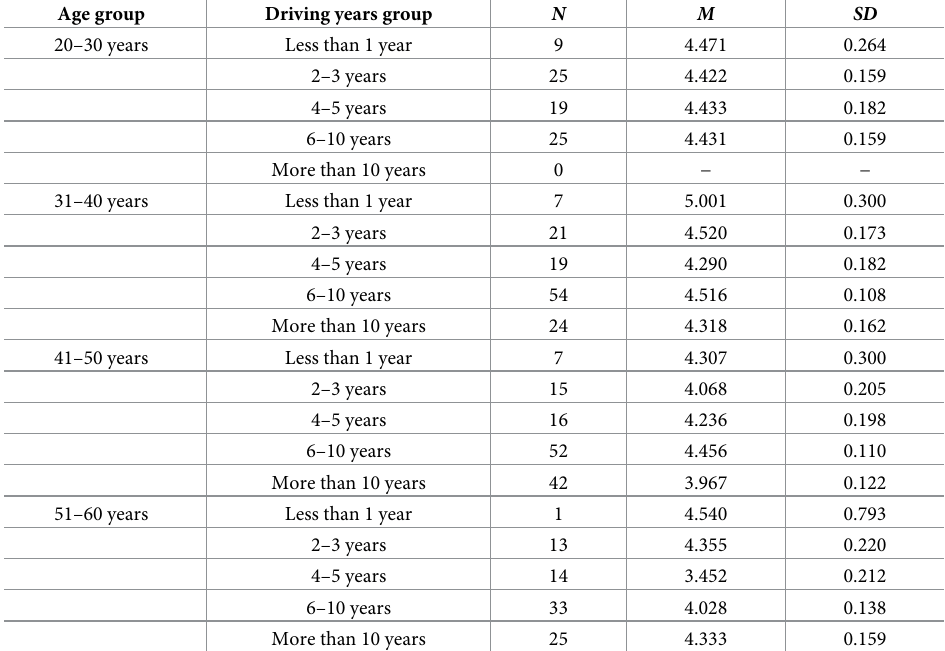
Table 5. The descriptive statistics of PDBS in different driving years groups and age groups ( N =